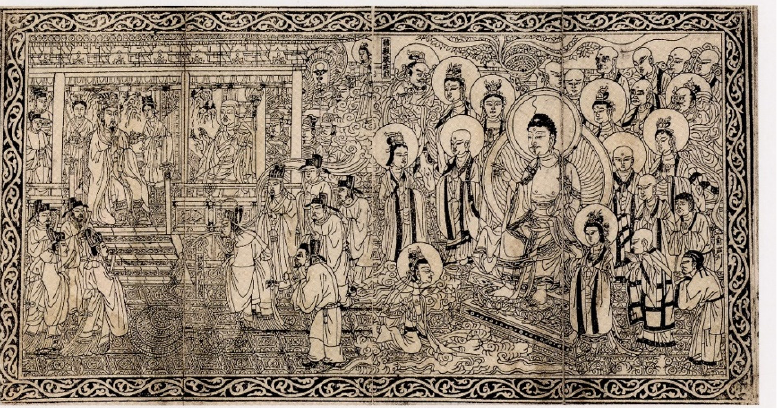
Figure 2. Liang Huang Repentance Liturgy from Repentance Rituals of Compassion Altar , 26.3 × 51.2 cm, Yuan dynasty (1302), National Library of China (Weng and Li 2014, vol. 4, p. 56).